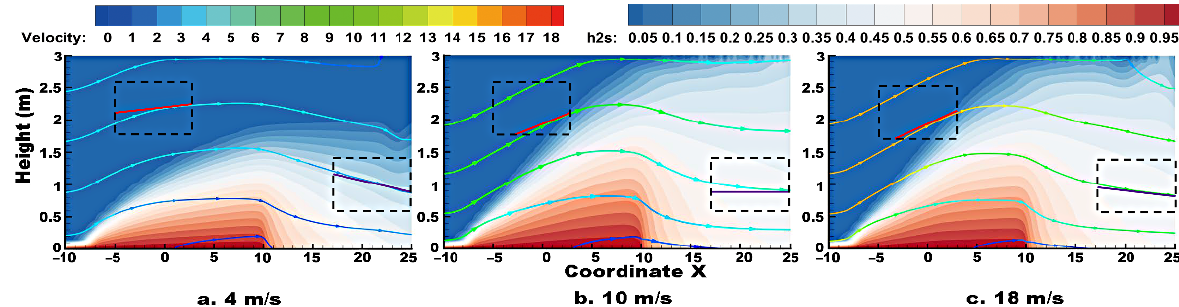
Figure 8. Streamline graphics of wind speed 4 m/s, 10 m/s, and 18 m/s case. The diagonal line in the dotted box represents the slope at the right end of the streamline in the box.